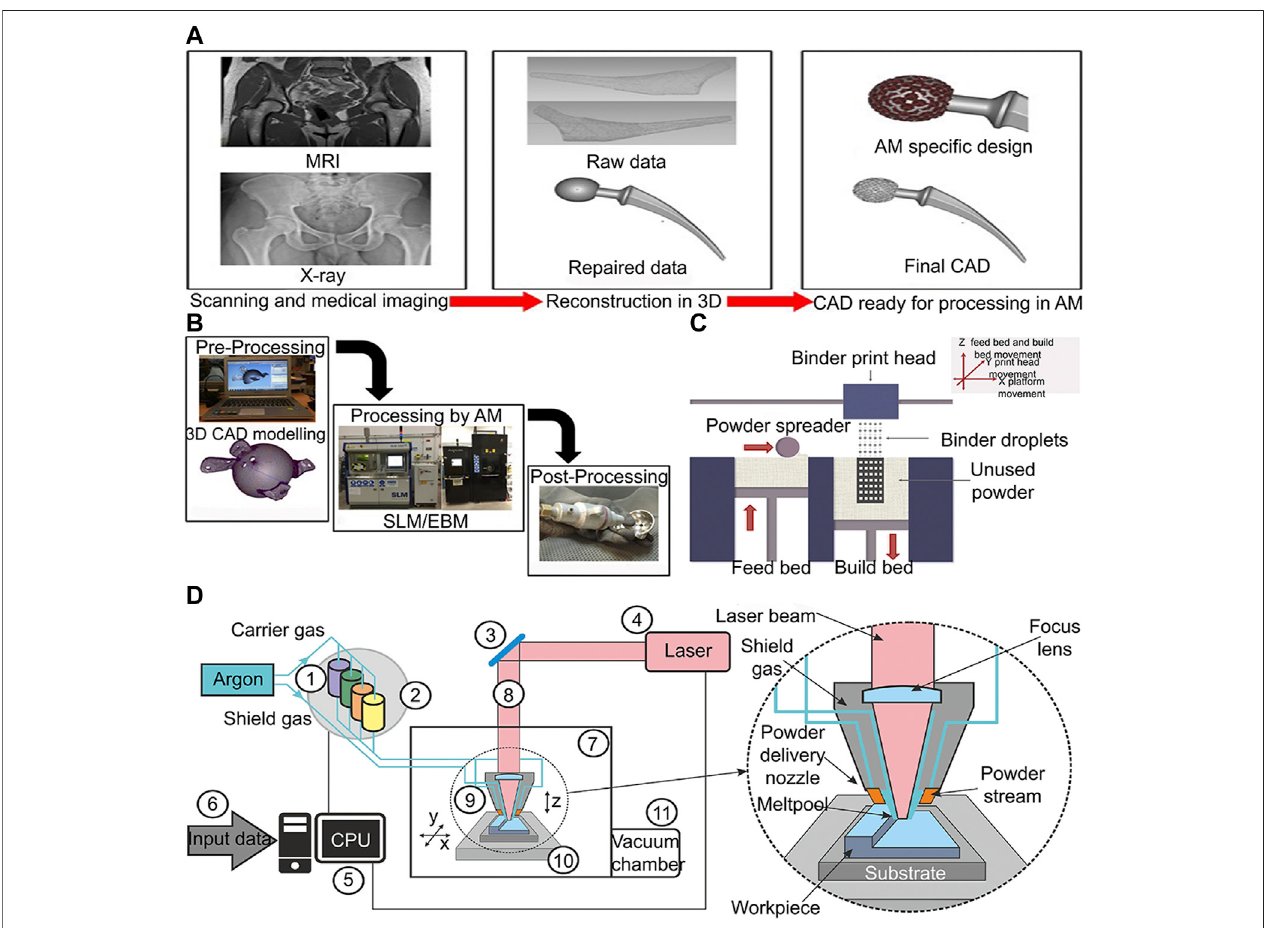
FIGURE 1 | 3D-printing of titanium alloy process diagram (A) 3D-printed customized implant data acquisition process (Sing et al., 2016). (B) Process chain for preparing orthopedic implants by 3D-printed technology (Sing et al., 2016). (C) Schematic diagram of powder bed process (Wang et al., 2017). (D) Lens process schematic diagram (Antolak-Dudka et al.,